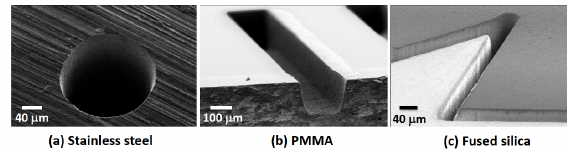
Figure 2: SEM images of different kinds of samples machined with a femtosecond laser, including (a) microdrilling of stainless steel, (b) groove formation in polymethyl methacrylate (PMMA), and (c) flexible cleaving of fused silica (courtesy of M.